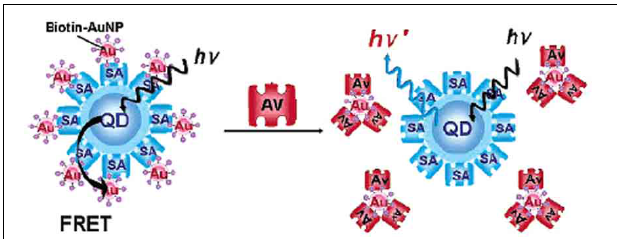
FIGURE 14 | Biotin-avidin system. Schematic of inhibition assay method based on the photoluminescence quenching of SA-QDs by Biotin-AuNPs. SA denotes the streptavidin immobilized on the surface of QDs, and Av is the externally added avidin (Feng et al., 2013). Reproduced with permission from Feng et al. (2013), Copyright